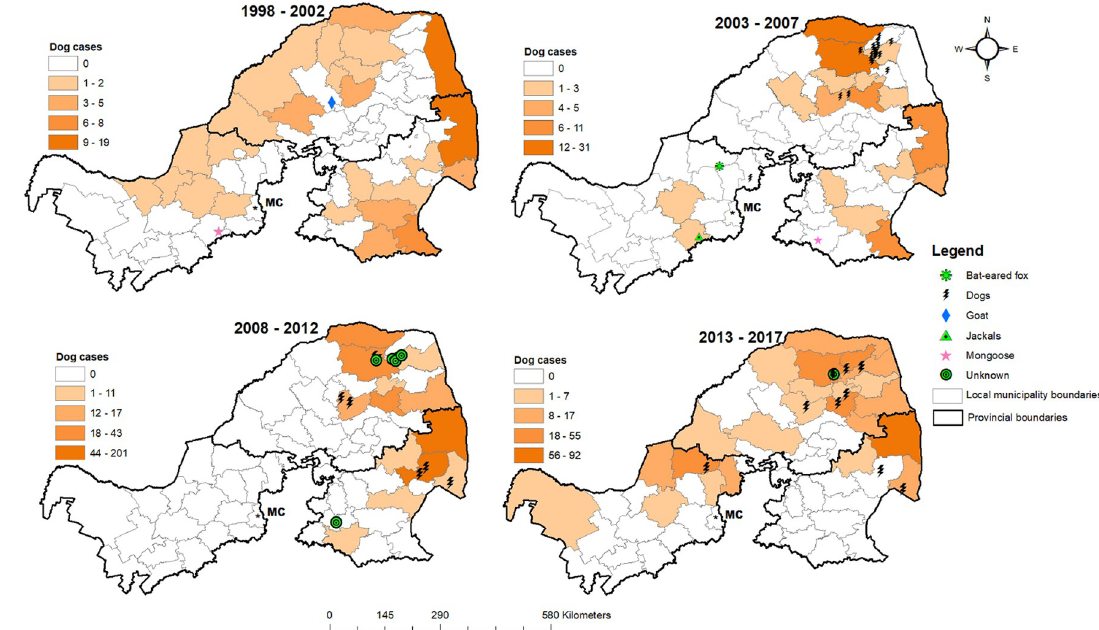
Fig 4. Choropleth maps of the distributions between 1998 and 2017 of dog rabies cases indicated per square kilometer by local municipality as a color gradient, and locations of human rabies victims shown by different colors and symbols indicating the source animals. < https://dataportal-mdb-sa.opendata.arcgis.com/ >